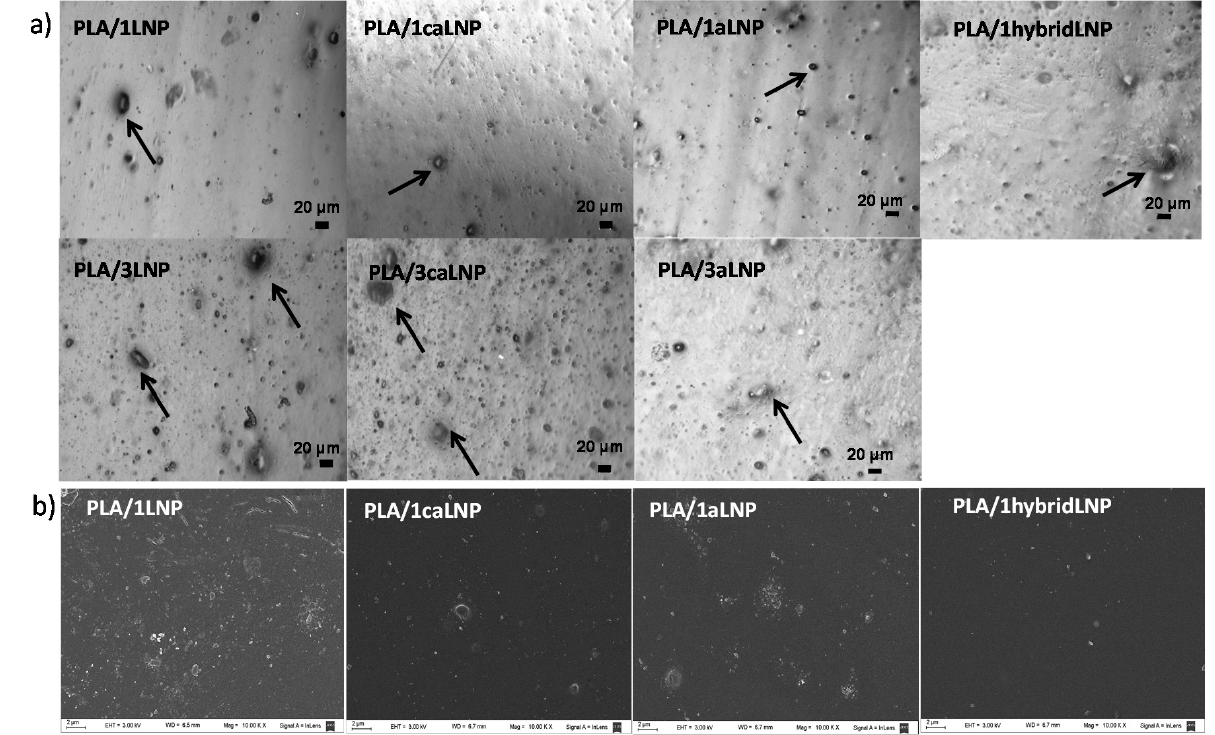
Figure 2. ( a ) Optical micrographs of PLA nanocomposite films and ( b ) FE-SEM micrographs of PLA nanocomposite films with 1 wt % of LNP, caLNP and aLNP.